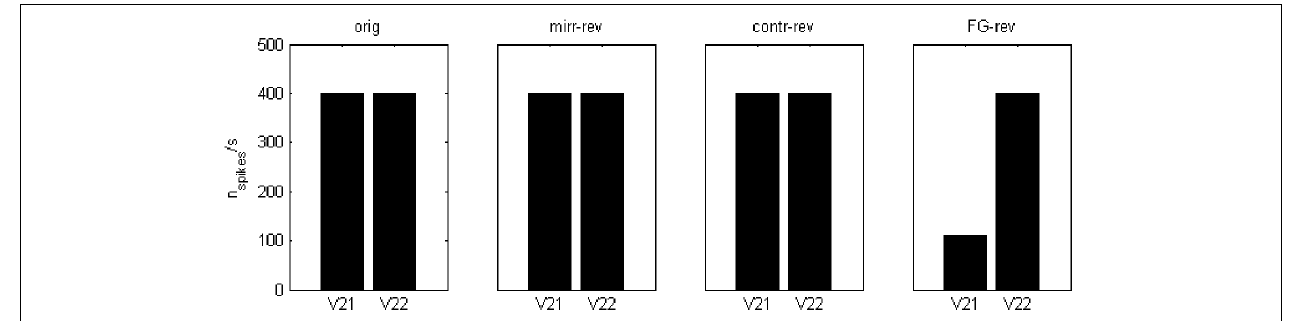
FIGURE 7 | Spiking rates, in number of spikes per second, for the area 2 potentials V 21 and V 22 at a point inside the “figural” region of the first image in Figure 2. These values were obtained after a 100ms simulation. In the case of FG-reversal, the spiking for “feature 1” is less frequent than for “feature 2.”